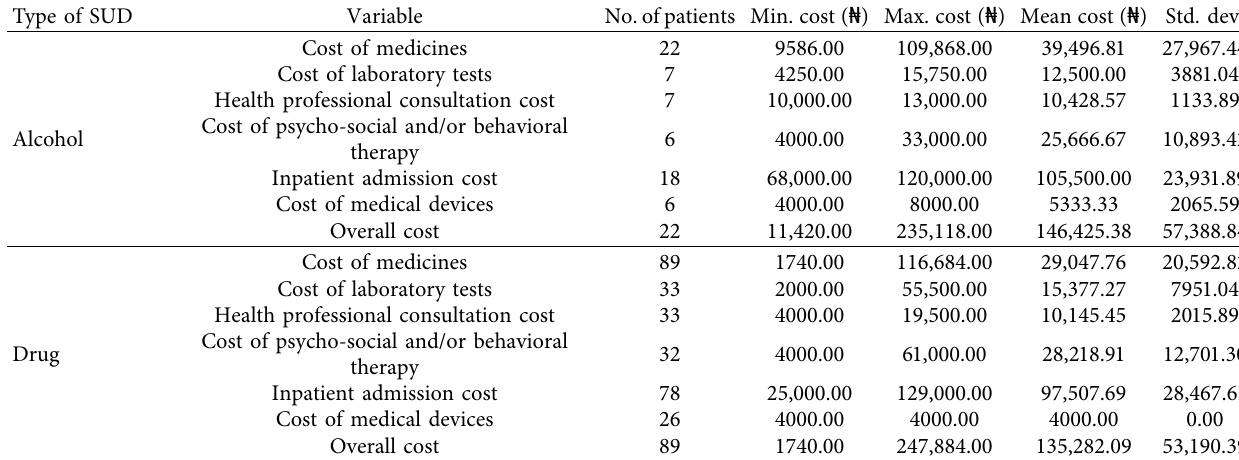
Table 2: Direct costs of treatment of substance use disorders #